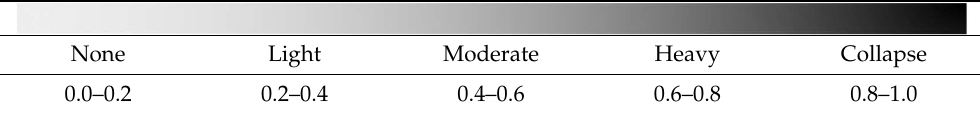
Table 3. Classification of the building damageability (compiled based on Ploeger [61]).